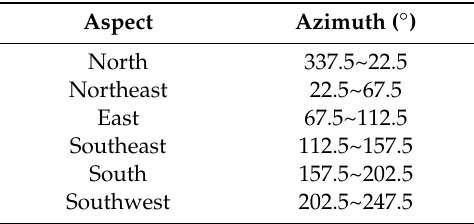
Table 3. Aspect classification